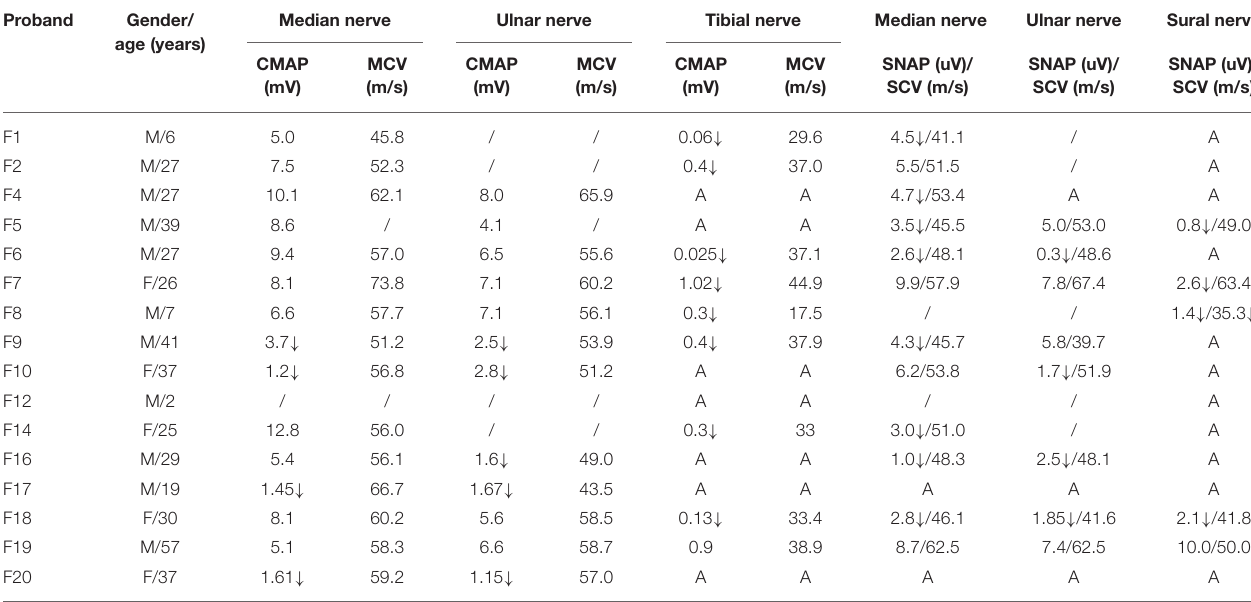
TABLE 2 | The electrophysiological findings of MFN2 pedigrees in our cohort. Proband Gender/ Median nerve Ulnar nerve Tibial age (years)